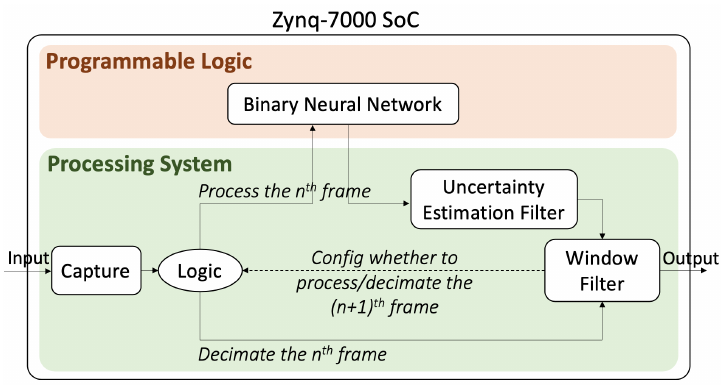
Figure 1. Overview of the